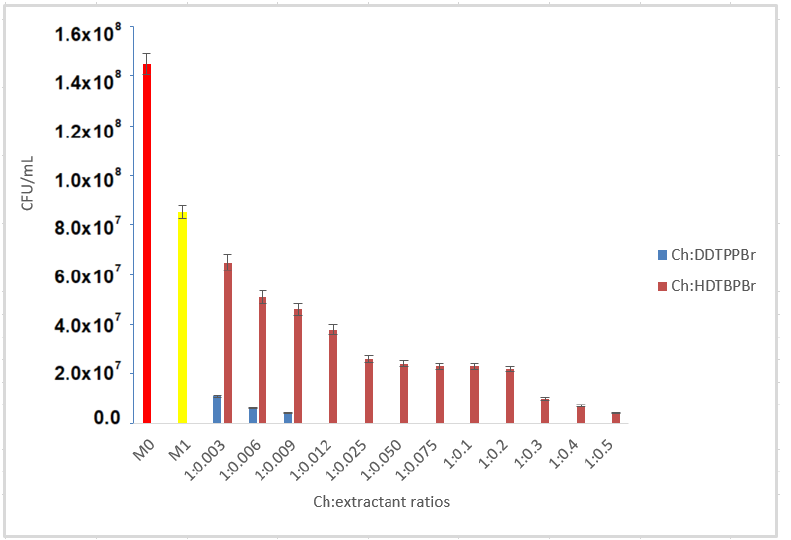
Figure 6. Comparison of control sample (M0)—Ch (M1)—Ch:functionalized with phosphorus heteroatom.